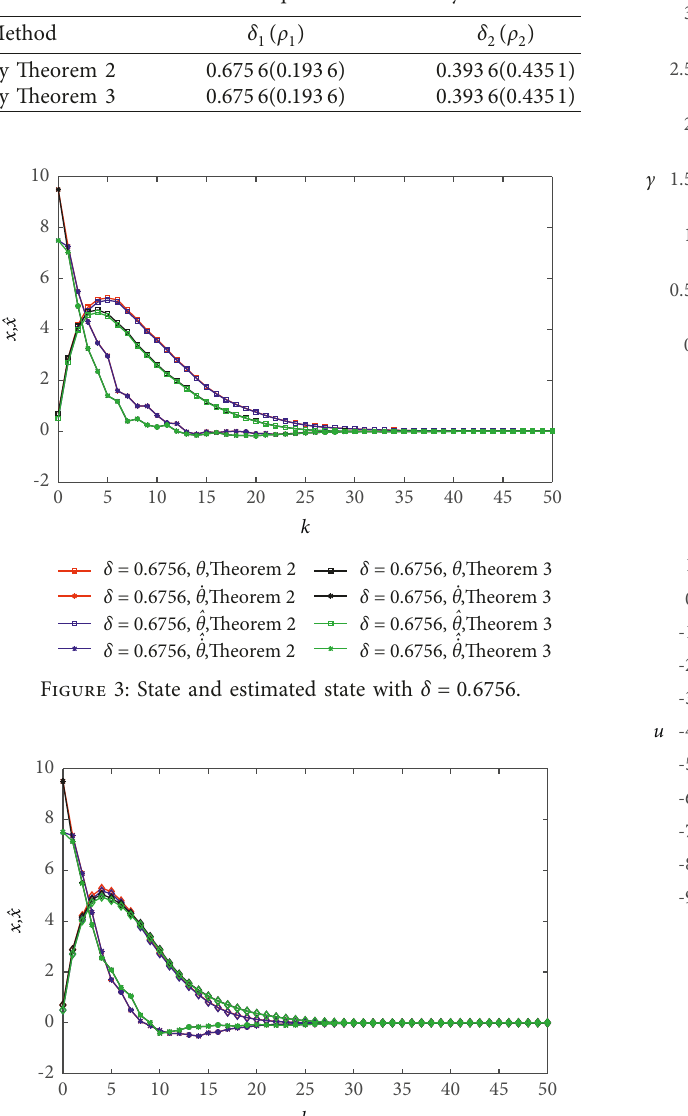
Figure 6: Control input signals.